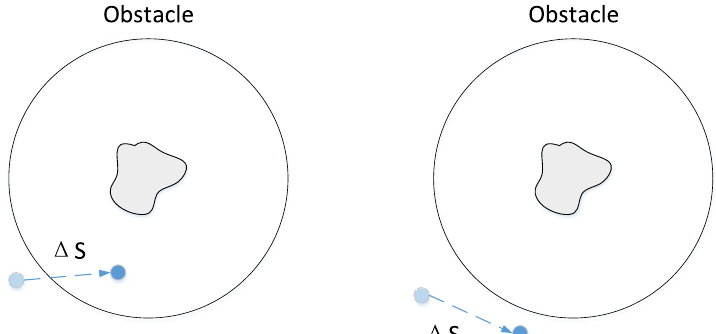
Fig. 10 Vehicle trajectory at time (cid:31) t